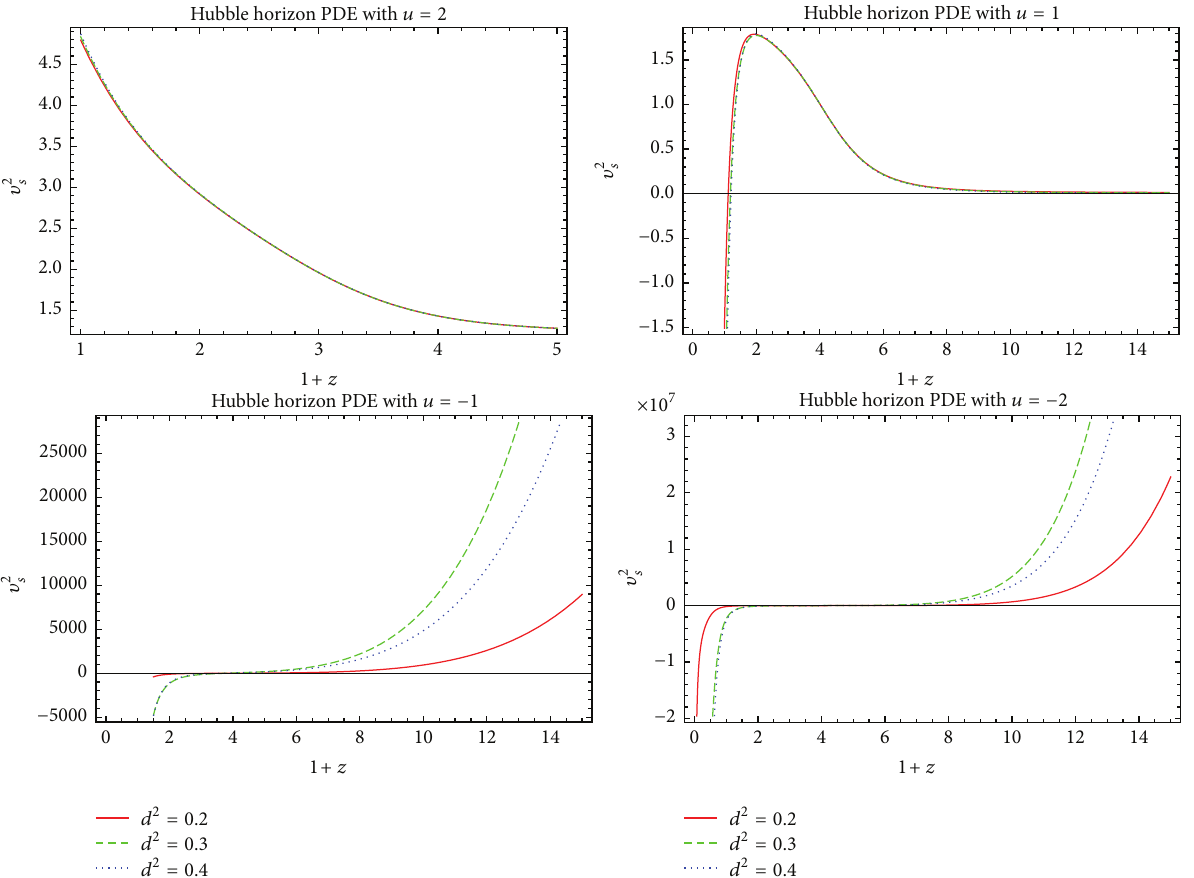
Figure 7: Plots of 𝜐 2 𝑠 versus 1 + 𝑧 for Hubble horizon PDE model in dynamical Chern-Simons gravity with 𝑢 = 2,1,−1, −2 .